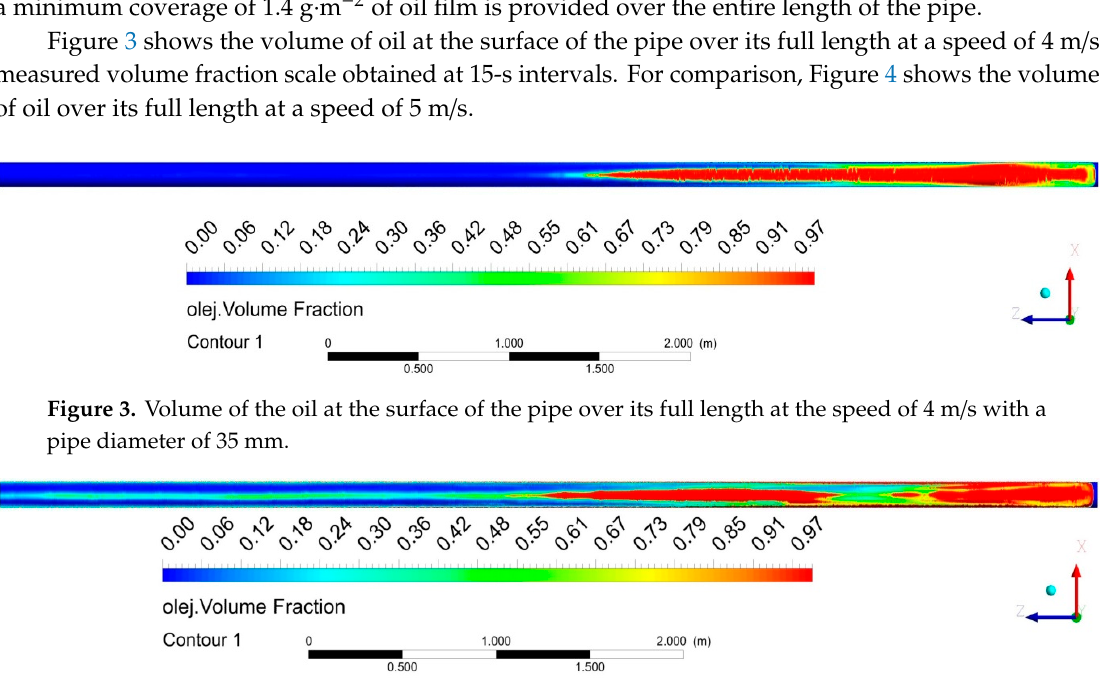
Figure 5. Plot of the areal density of oil at three different velocities on an inner pipe with a diameter of 25 mm pipe. The more even distribution of the oil film was evident only at a speed above 5.5 m/s with a pipe diameter of 25 mm. Comparable results between the numerical calculation and the experiment could only be seen at the speed of 7 m/s. Figures 6 and 7 show oil volume distribution at an air flow rate of 5.5 and 7 m/s respectively. Figure 6. Volume of the oil at the surface of the pipe over its full length at the speed of 5.5 m/s with a pipe diameter of 25 mm.